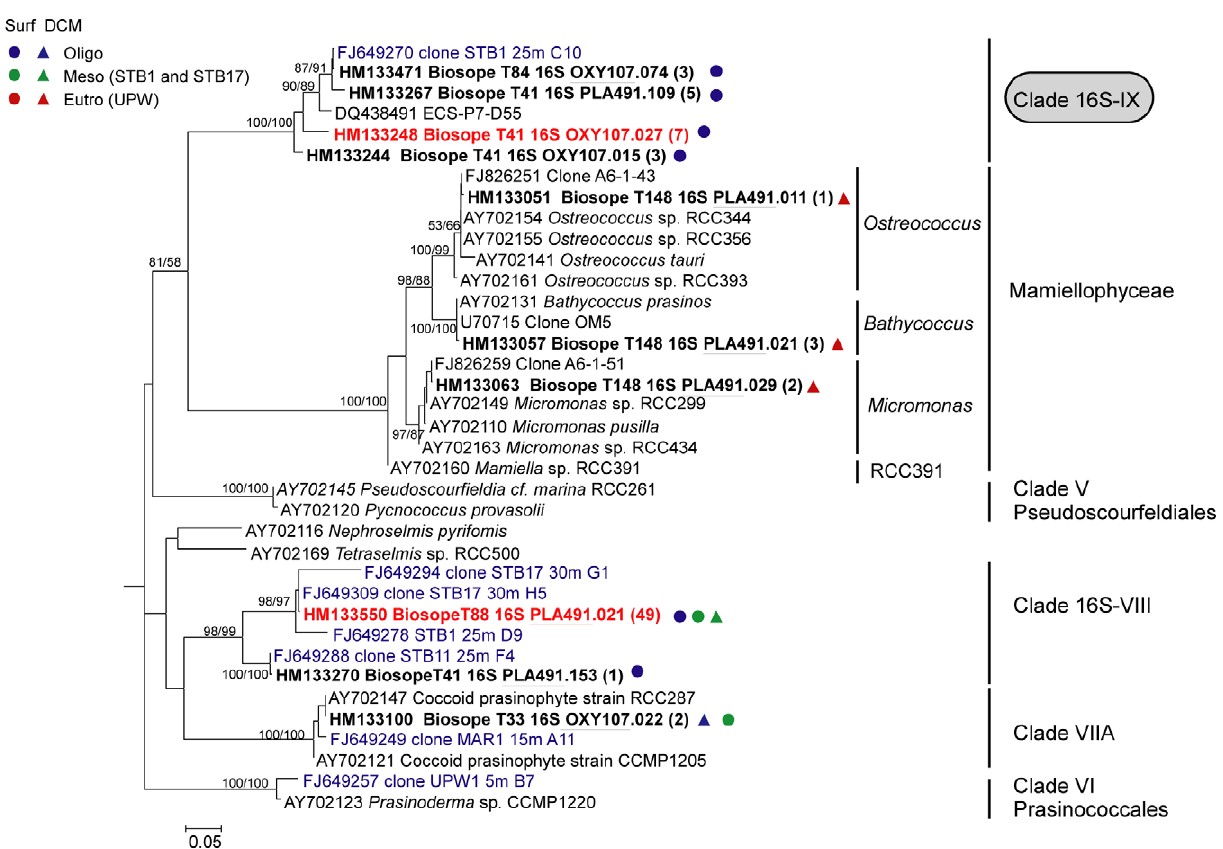
Figure 4. Phylogenetic tree of plastid 16S rRNA gene sequences for Chlorophyta. The tree is inferred from 710 positions of an alignment of 37 partial sequences. See legend of Fig. 2 for details. The novel prasinophyte clade 16S-IX is